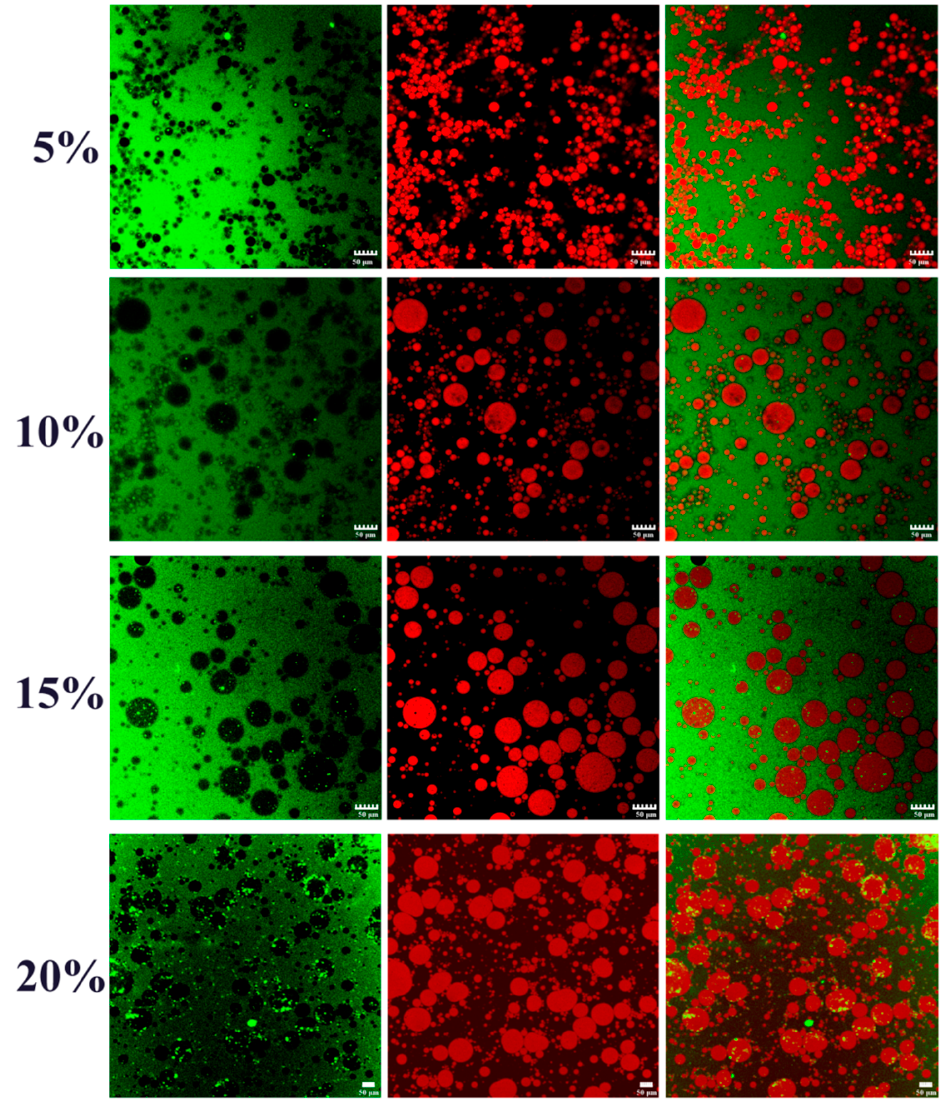
Figure 2. CLSM observations (dilute the sample 10 times) of the W 1 /O/W 2 emulgels with different additions of W 1 /O emulsion (5, 10, 15, and 20%). The oil phase and outer aqueous phase (W 2 , 1.0 wt% SSPs) were dyed with the Nile red and FITC, respectively. Scale bars, 50 μ m.